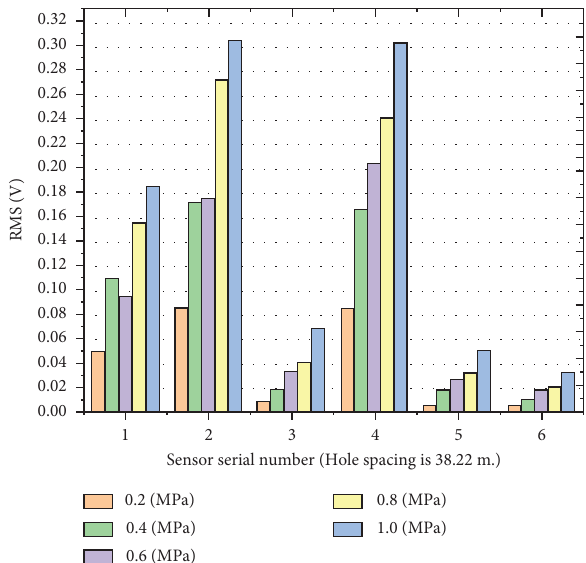
Figure 9: Variation of the leakage acoustic signal RMS value of A and C leakage with the distance under diferent